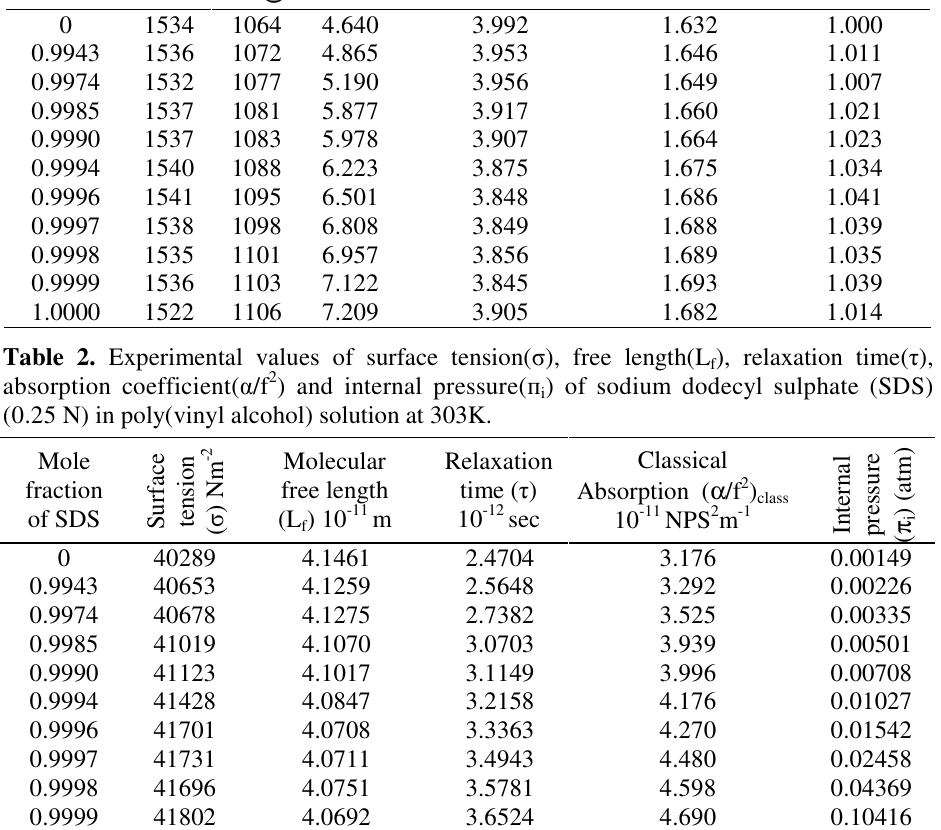
Table 1. Experimental values of ultrasonic velocity (U), density ( ρ ), viscosity ( η ), adiabatic compressibility ( β ), acoustic impedance (Z) and relative association (R ad dodecyl sulphate (SDS) (0.25 N) in poly (vinyl alcohol) solution at 303K